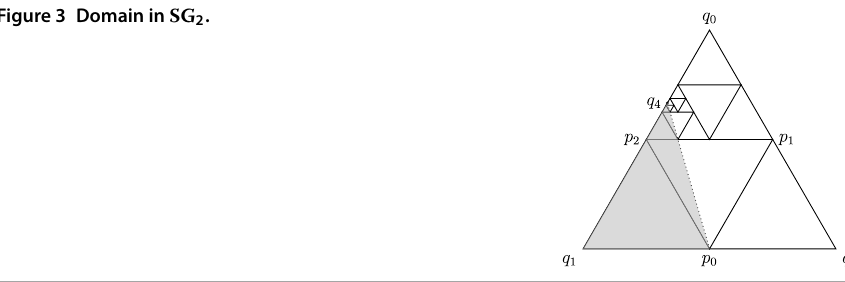
Figure 3 Domain in SG 2